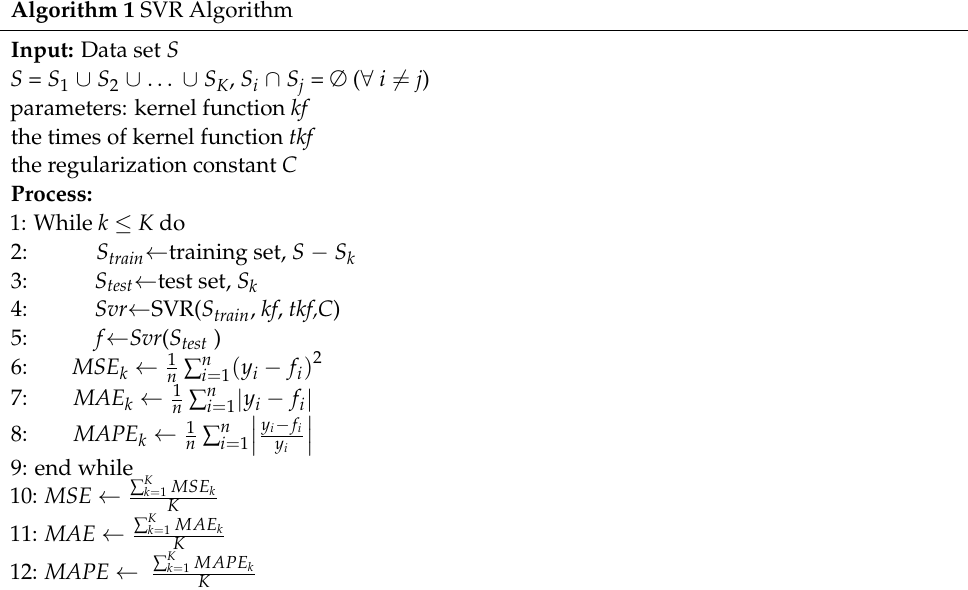
Algorithm 1 SVR